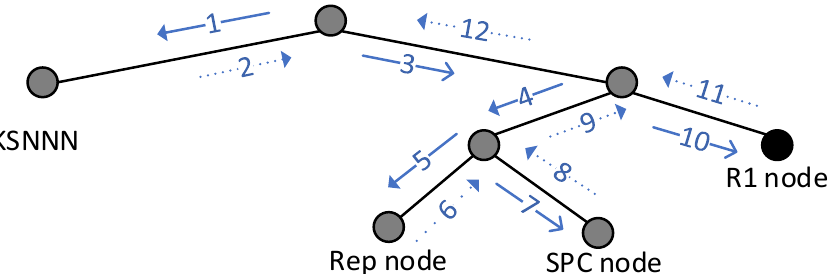
Figure 12. Schematic diagram of the decoding process based on traditional subcodes combined with KSNNN.